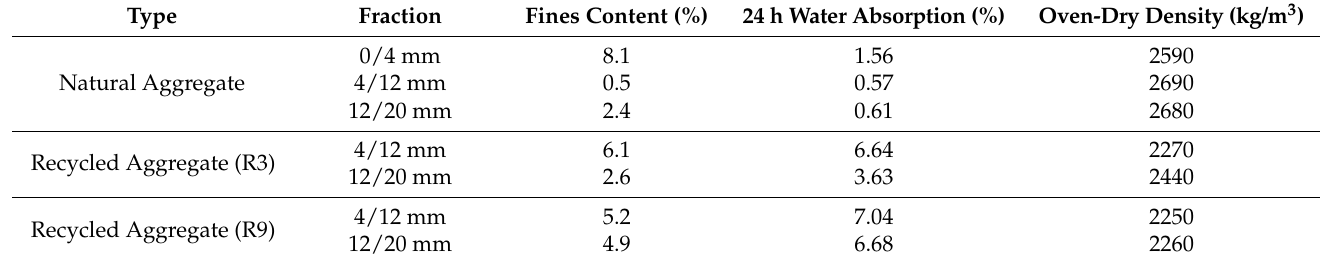
Table 1. Physical properties of the aggregate.